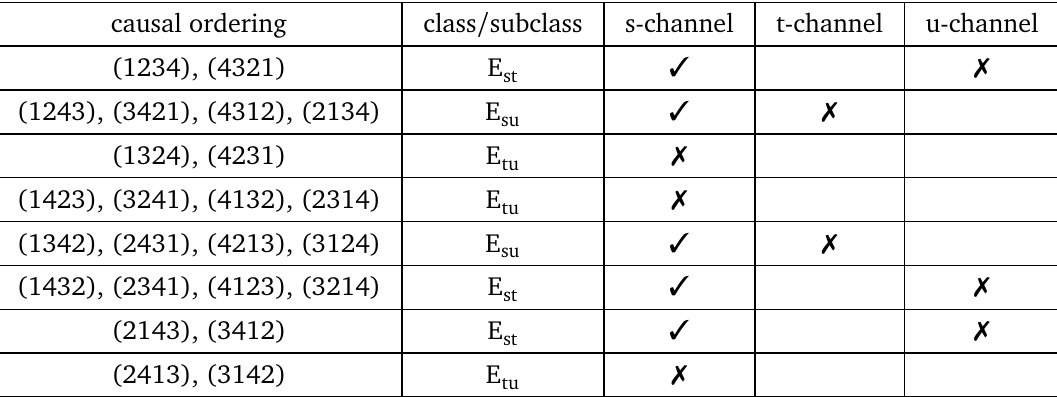
Table 4: The classes / subclasses of type 1 causal